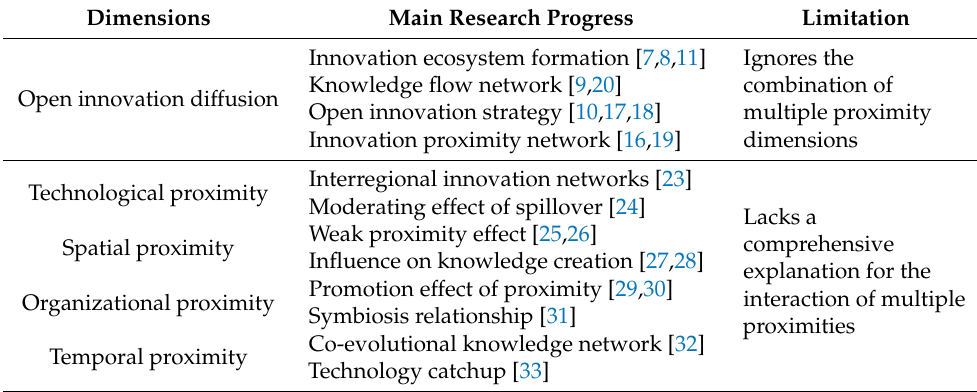
Table 1. Summary of the related research